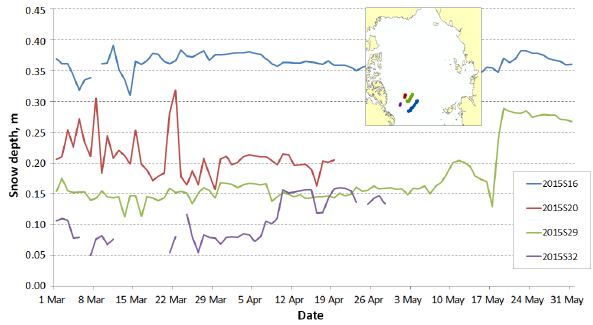
Figure 13. Snow depth AWI buoy in the MAM months of 2016. All buoys measured snow depth on the second-year ice. The plots show daily averages of snow depth from four